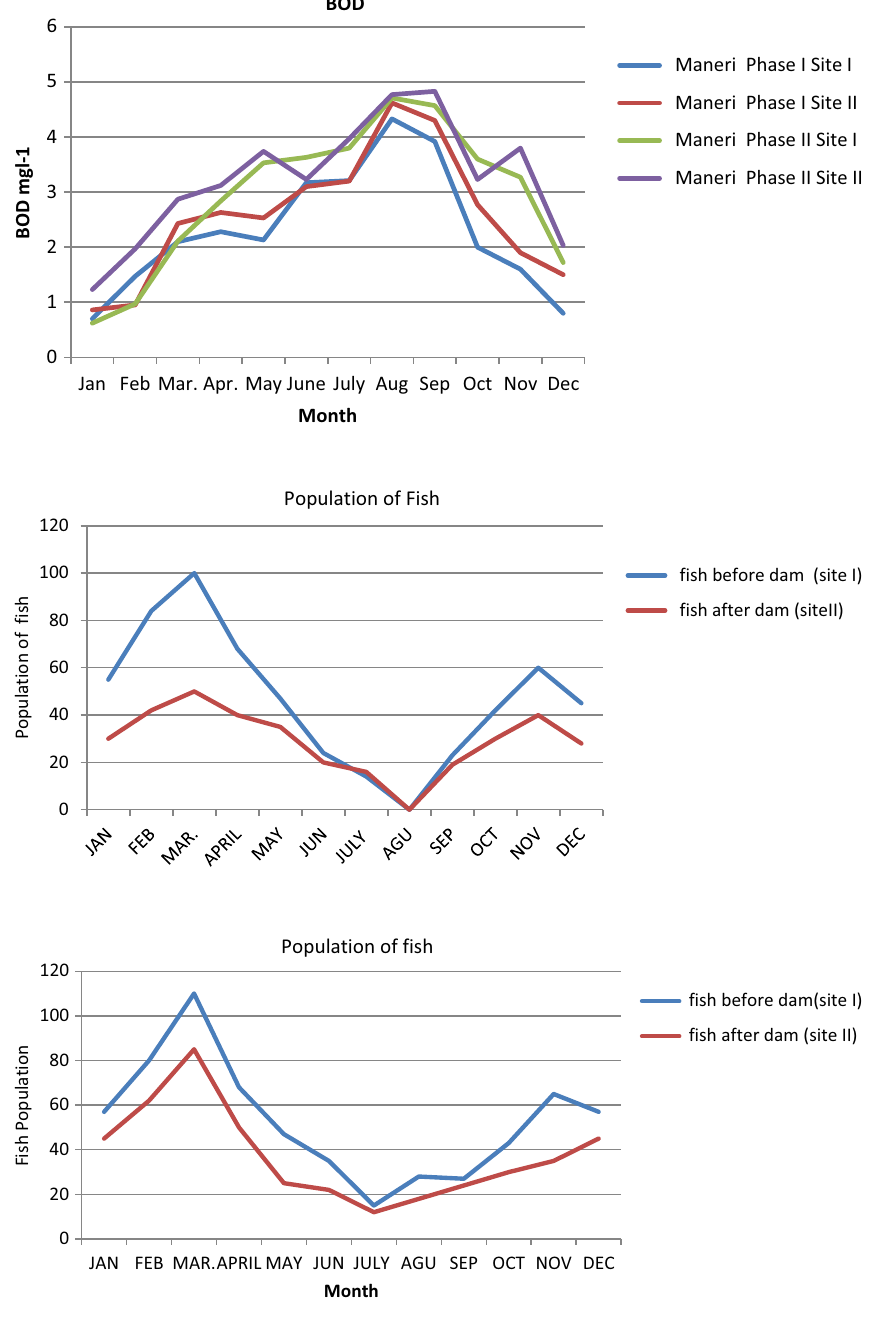
Fig. 13 Monthly variation in